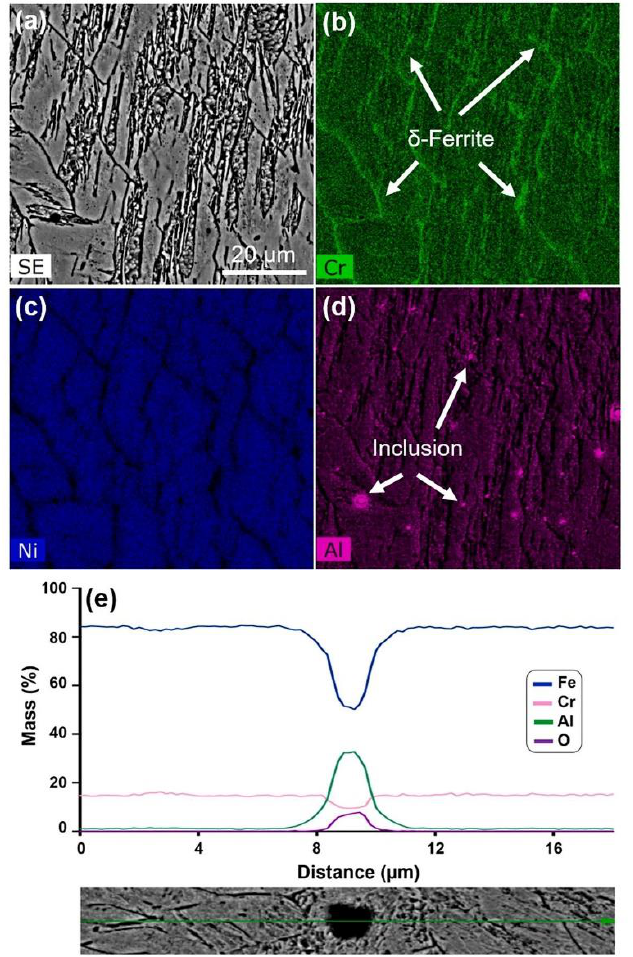
Figure 13. The chemical elemental mapping and line profiles selected from the as-printed microstructure of wire arc addictive manufactured PH13-8Mo steel [160]: ( a ) SEM image; ( b – d ) chemical elemental mappings; ( e ) the line profiles of selected region. (Reprinted with permission from Ref. [160]. Copyright 2022 Elsevier).